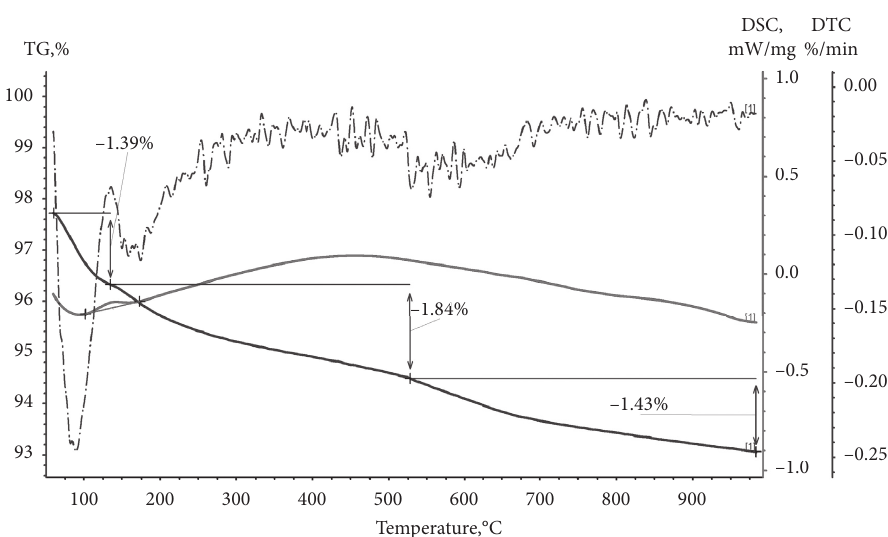
Figure 4: Differential thermoanalysis of the composition of dust zircon (5 mass units) and H